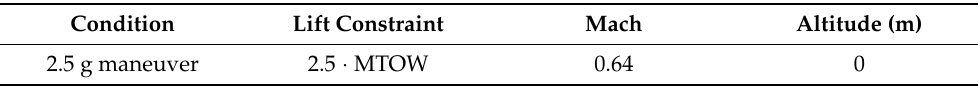
Table 6. Critical-aerodynamic-loading